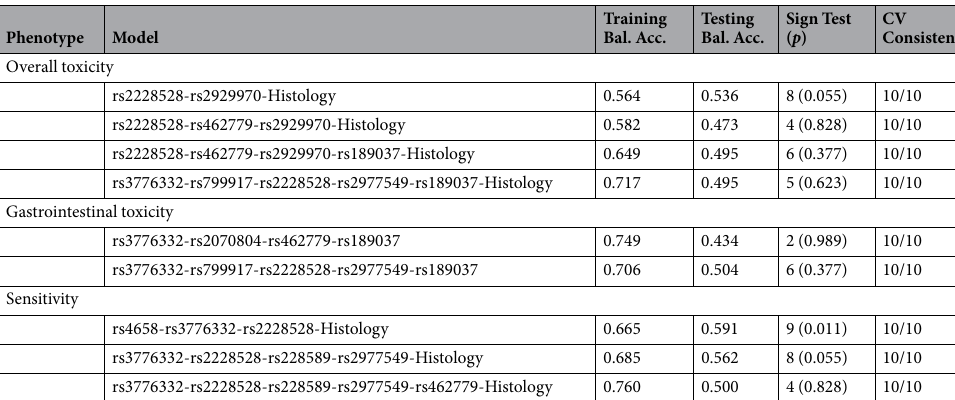
Table 4. Multi-dimensional gene-environment interaction in validation